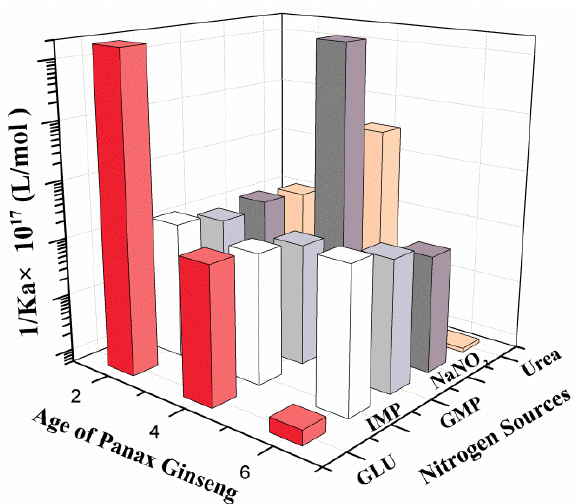
Figure 4. Column chart comparing the sensitivities (1/Ka) of the ginseng root meristems at each age to five different nitrogen